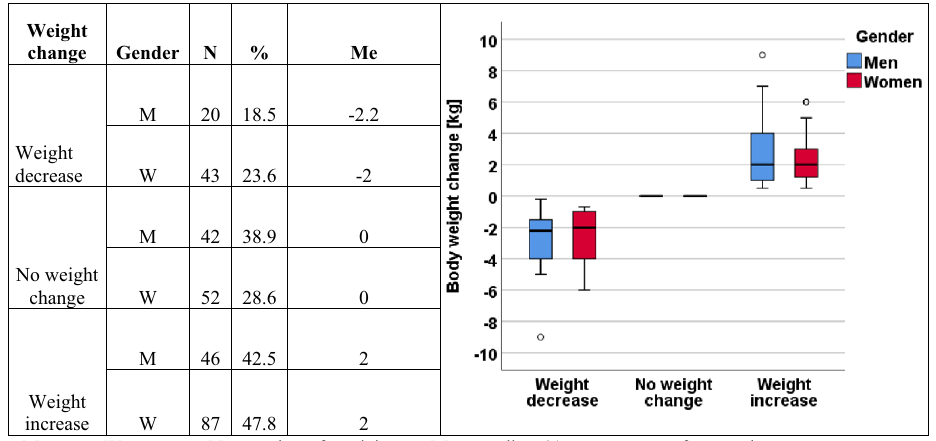
Figure 1. Changes in the body weight of men and women, including differences before and during lockdown. M men, W women, N number of participants, Me median, % percentage of respondents.